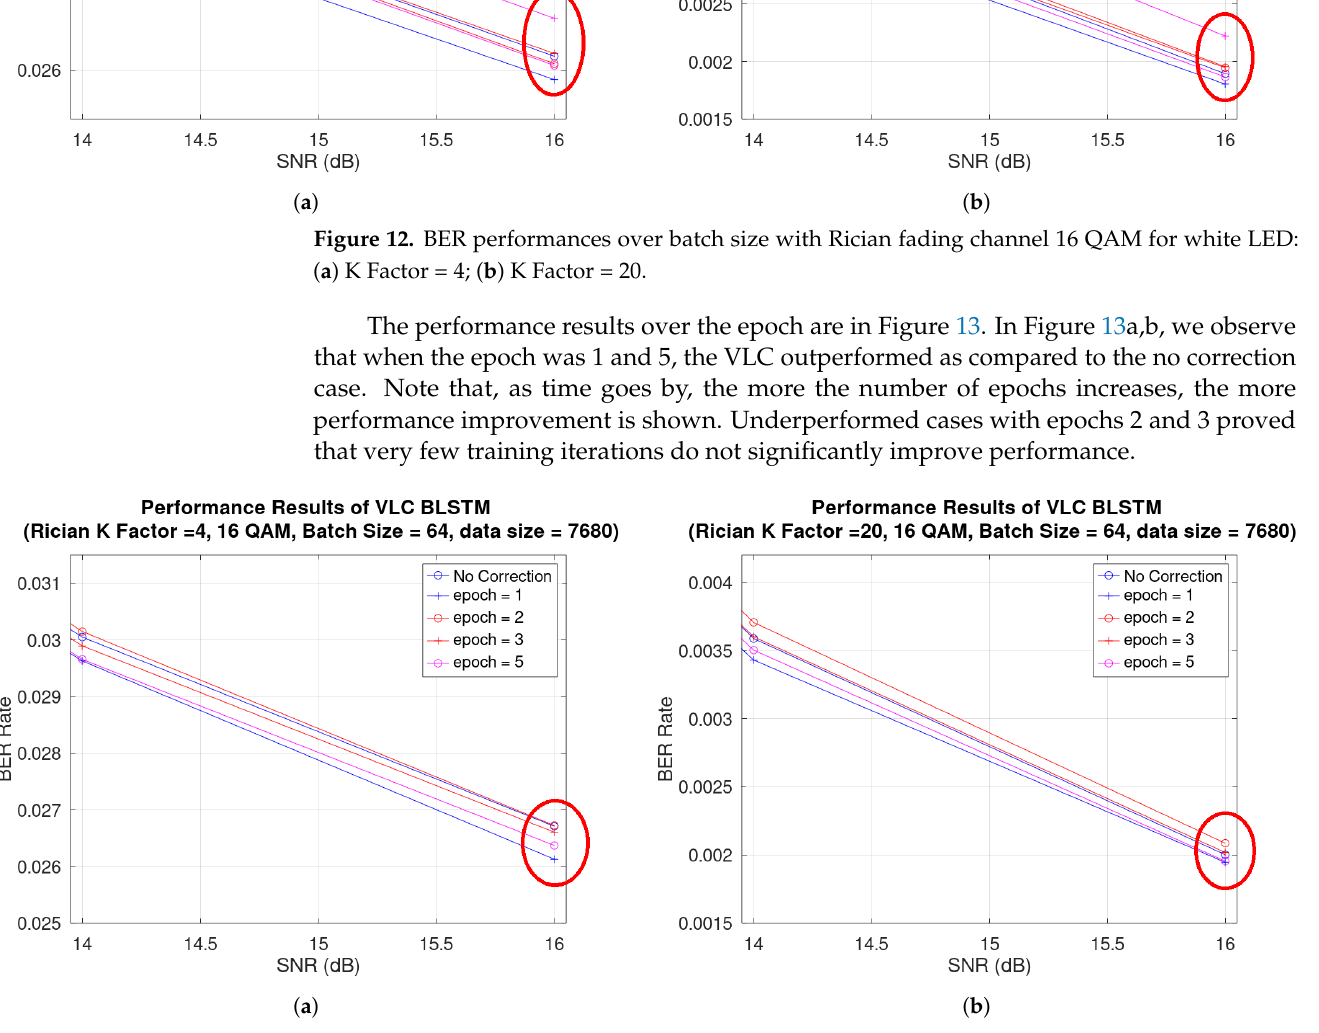
Figure 13. BER performances over epoch with Rician fading channel 16 QAM for white LED: ( a ) K factor = 4; ( b ) K factor =